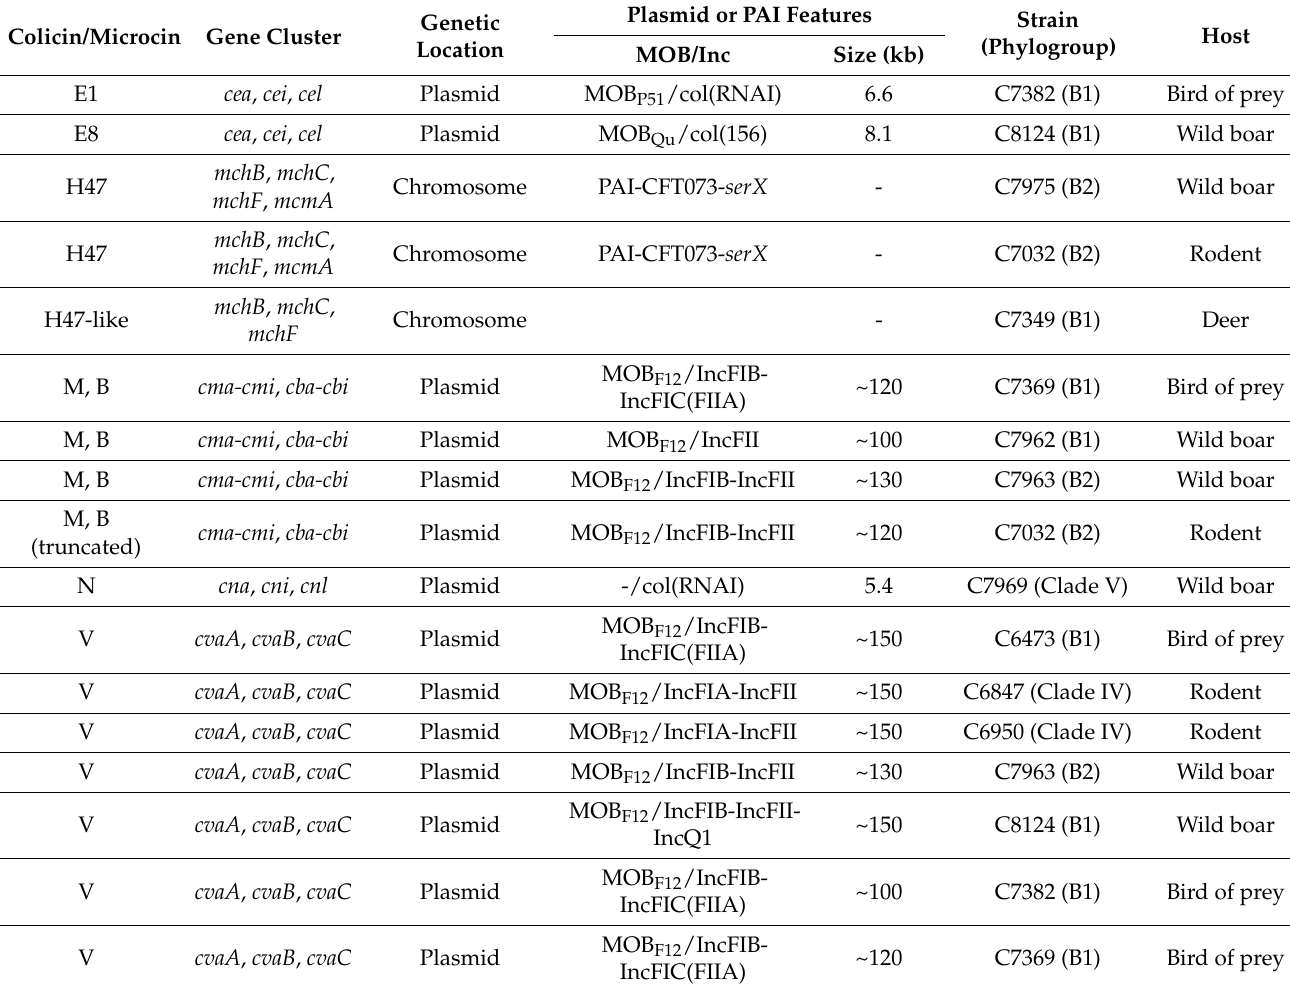
Table 3. Distribution and genetic location of bacteriocins encoding genes among commensal E. coli from wildlife. Colicin/Microcin Gene Cluster